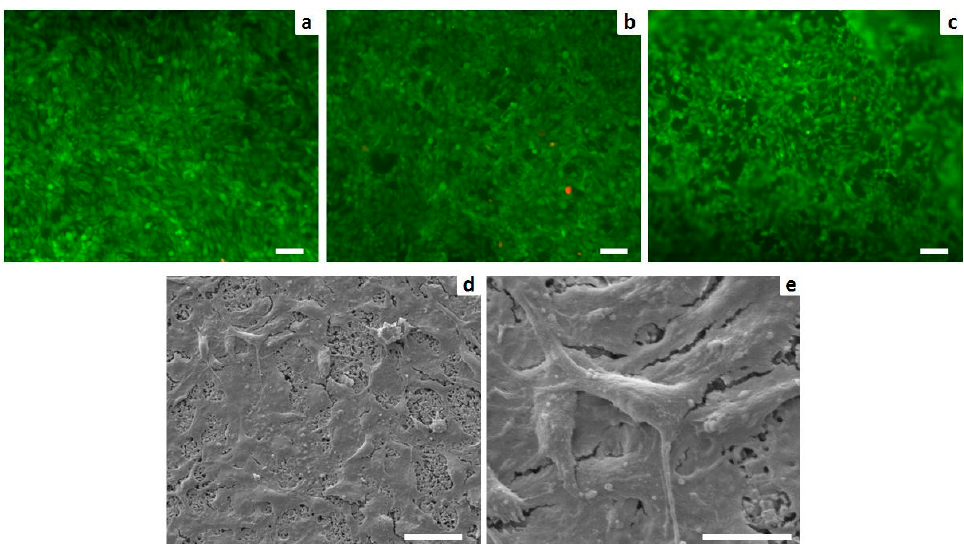
Figure 8. Cell viability analyzed by the live/dead assay: Calcein AM stains for live cells in green, EthD-1 stains for dead cells in red. ( a ) Sr0; ( b ) Sr2; and ( c ) Sr5 (scale bars: 100 µm); and analysis of cell morphology assessed by SEM: ( d ) MG63 grown for three days on Sr2 surface (scale bar: 50 µm) with a higher power view showing details of the cell plasma extensions ( e ) (scale bar: 20 µm).